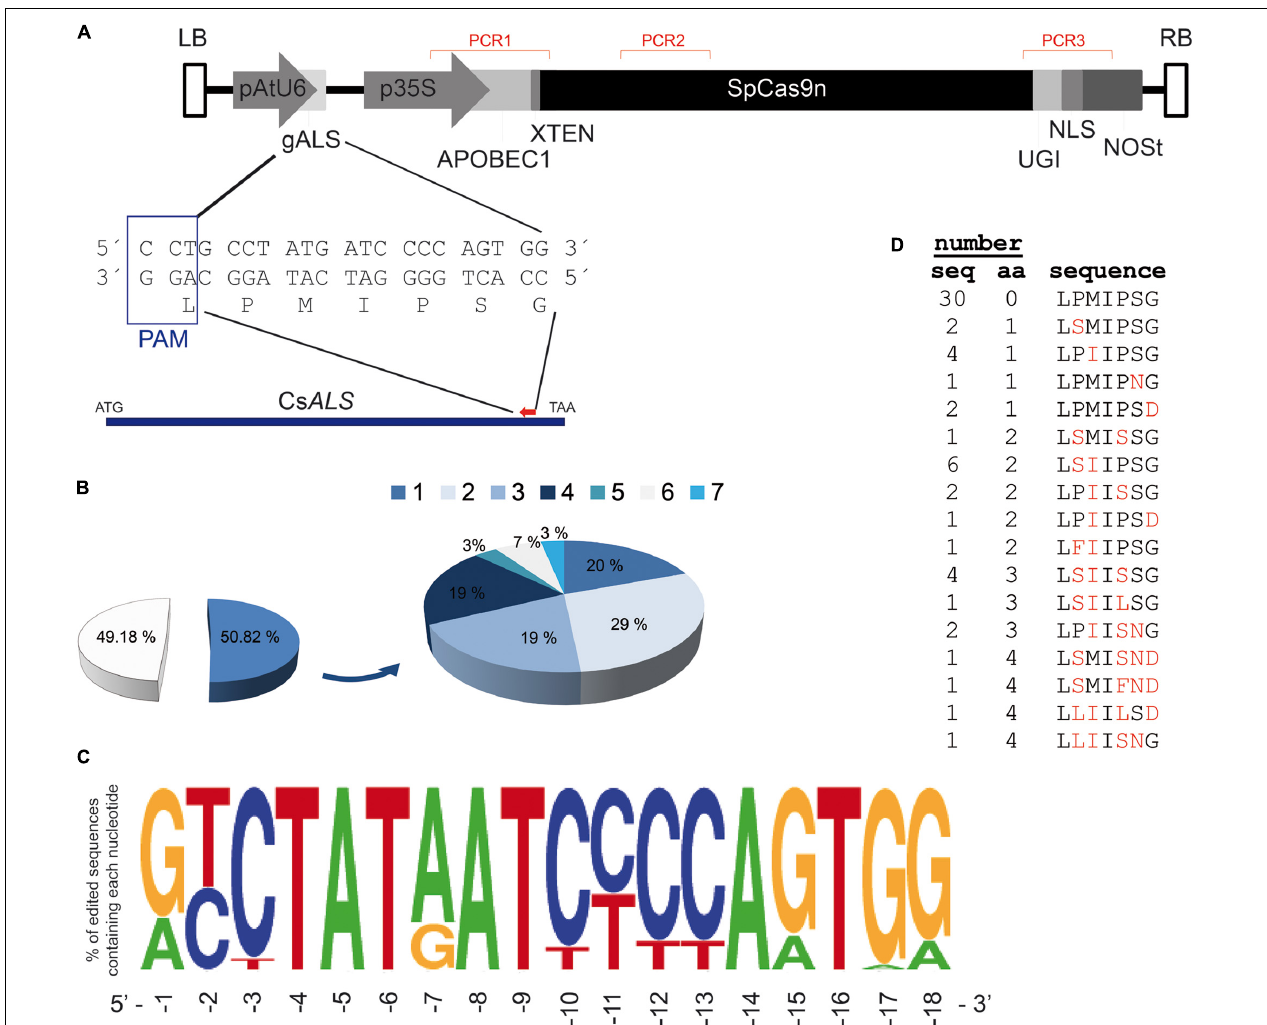
FIGURE 3 | (A) Schematic representation of the T-DNA used to edit the endogenous citrus ALS gene. LB and RB, left and right T-DNA borders, respectively; pAtU6 and p35S, Arabidopsis thaliana polIIIU6 and CaMV 35S promoters, respectively; gALS, gRNA targeting ALS ; APOBEC1, cytidine deaminase from rat; SpCas9n (SpCas9 D10A nickase mutant); UGI, Bacillus subtilis uracil DNA glycosylase inhibitor; NLS, nuclear localization signal of SV40 (simion virus 40) large T antigen; NOSt, nopaline synthase gene terminator sequence. Red-marked regions PCR1, PCR2, and PCR indicate target amplicons to test T-DNA insertion (further details in Supplementary Figure 4 ). The approximate position of gRNA on the CsALS genomic sequence, with its corresponding nucleotides in the gene, is marked by a red triangle. (B) Percentage of escapes (49.18%) and edited events (50.82%) from the total of non-transgenic regenerants (288 shoots). Edited shoots presented from one to up to seven C/G → T/A conversions. (C) Graphical representation of deamination efficiency found at the different nucleotide positions of the target sequences. Numbers under the sequence indicate nucleotide positions from the PAM sequence. (D) Amino acid sequences of the target sequence from non-transgenic regenerant events. The number of events (seq) and amino acid changes (aa, highlighted with red letters in last column) found for each peptide sequence are